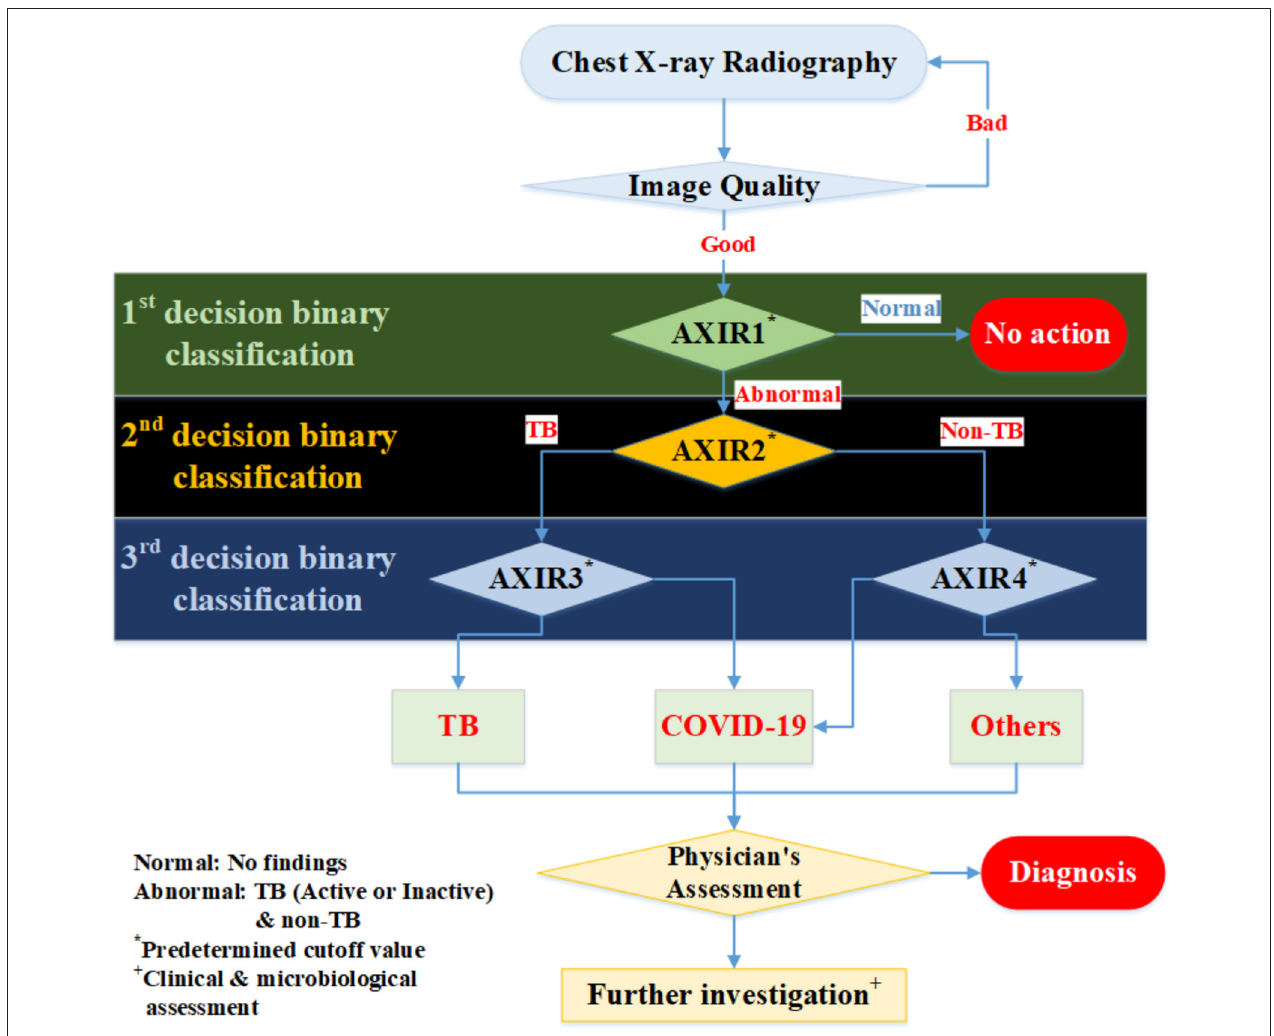
FIGURE 1 | Workflow for determining whether chest X-ray image shows a normal, tubercular (TB), or COVID-19 infected lung. AXIR (Automated X-ray Imaging Radiography system).